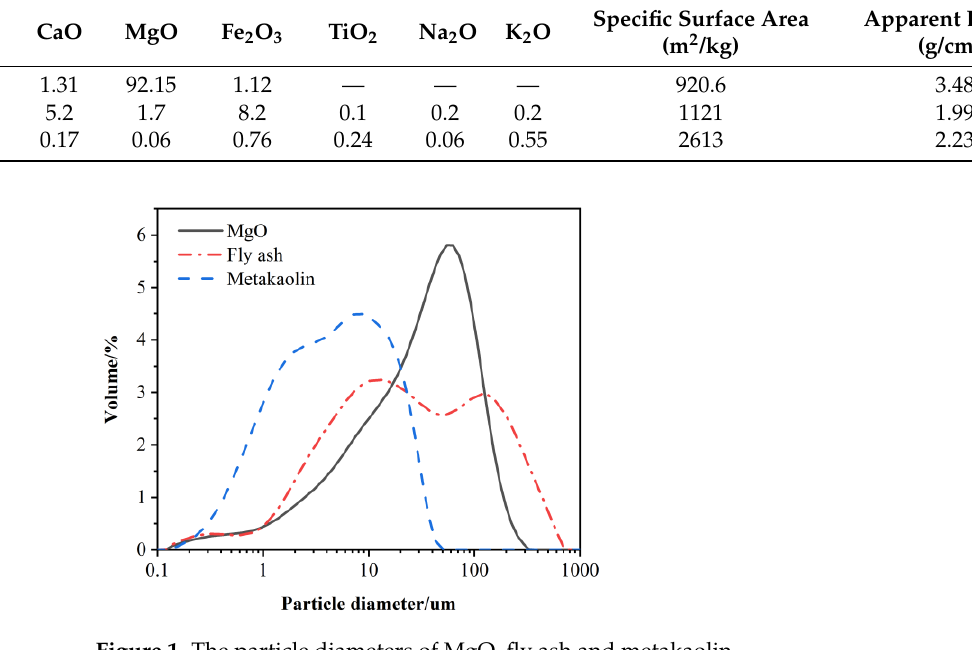
Figure 1. The particle diameters of MgO, fly ash and metakaolin.